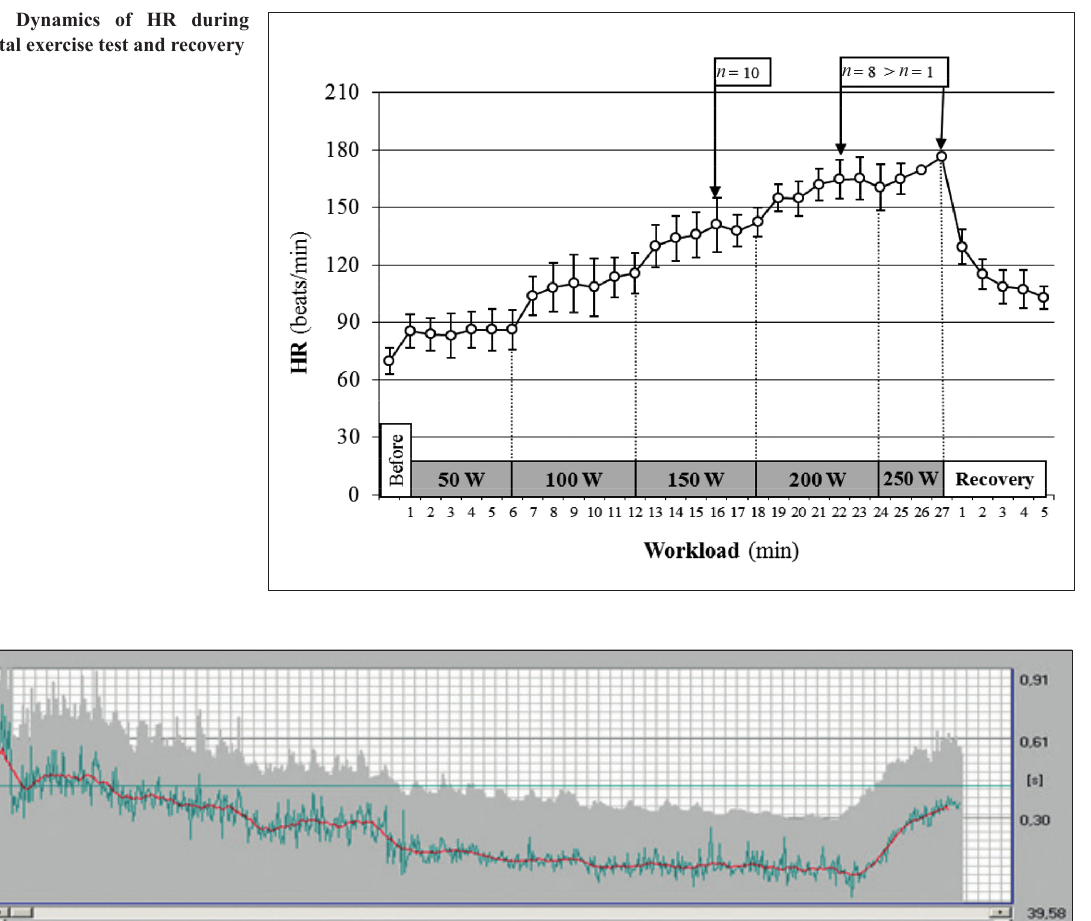
Figure 3. Dynamics of discriminants between RR intervals and ST-segment depression during incremental exercise test and recovery Notes. X axis – discriminant value (left); RR intervals, s (right). Y axis – time, min Grey (background) shows dynamics of RR intervals of ECG; Green line – discriminant; red line – discriminant averaged of 10